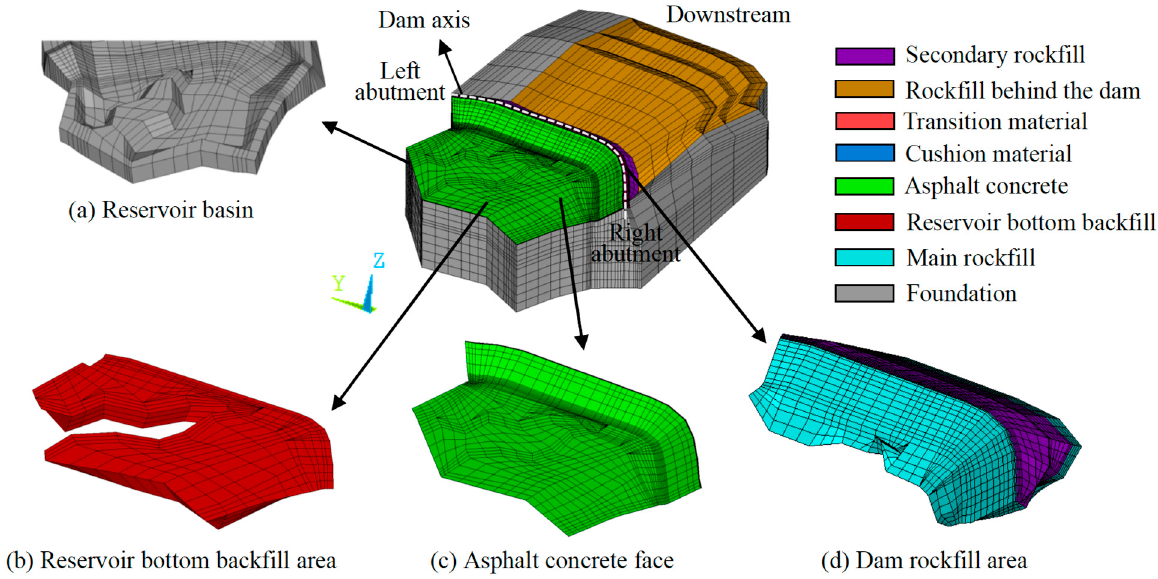
Figure 3. Three-dimensional finite element mesh of the calculation zone: ( a ) reservoir basin; ( b ) reservoir bottom backfill area; ( c ) asphalt concrete face; ( d ) dam rock area.